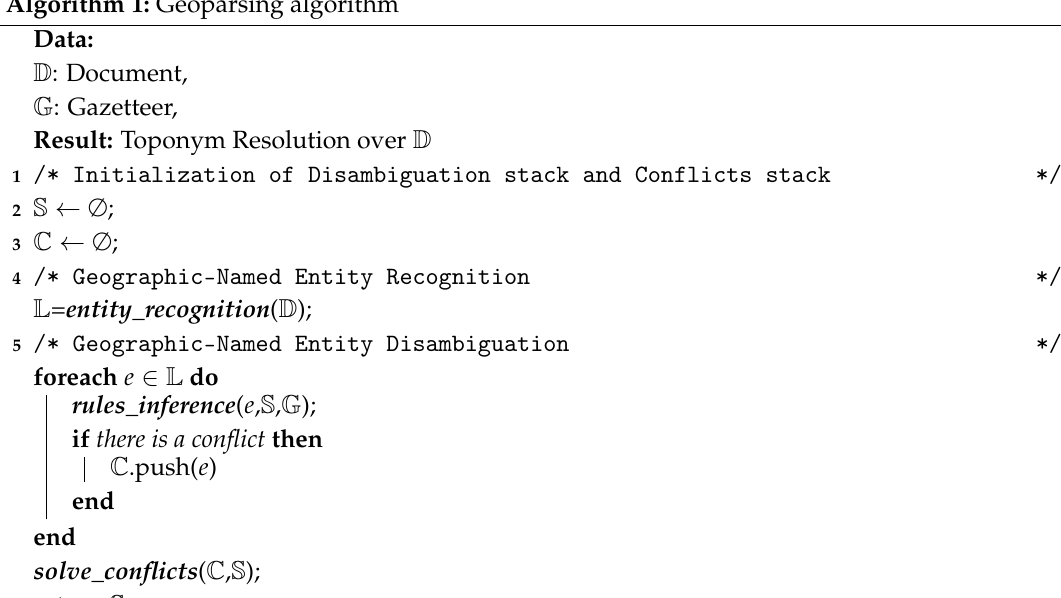
Algorithm 1: Geoparsing